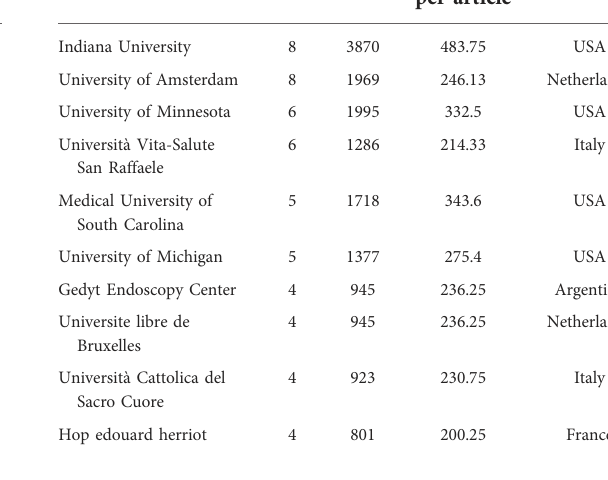
TABLE 1 countries or regions published at least three articles . TC=Total citations. Country